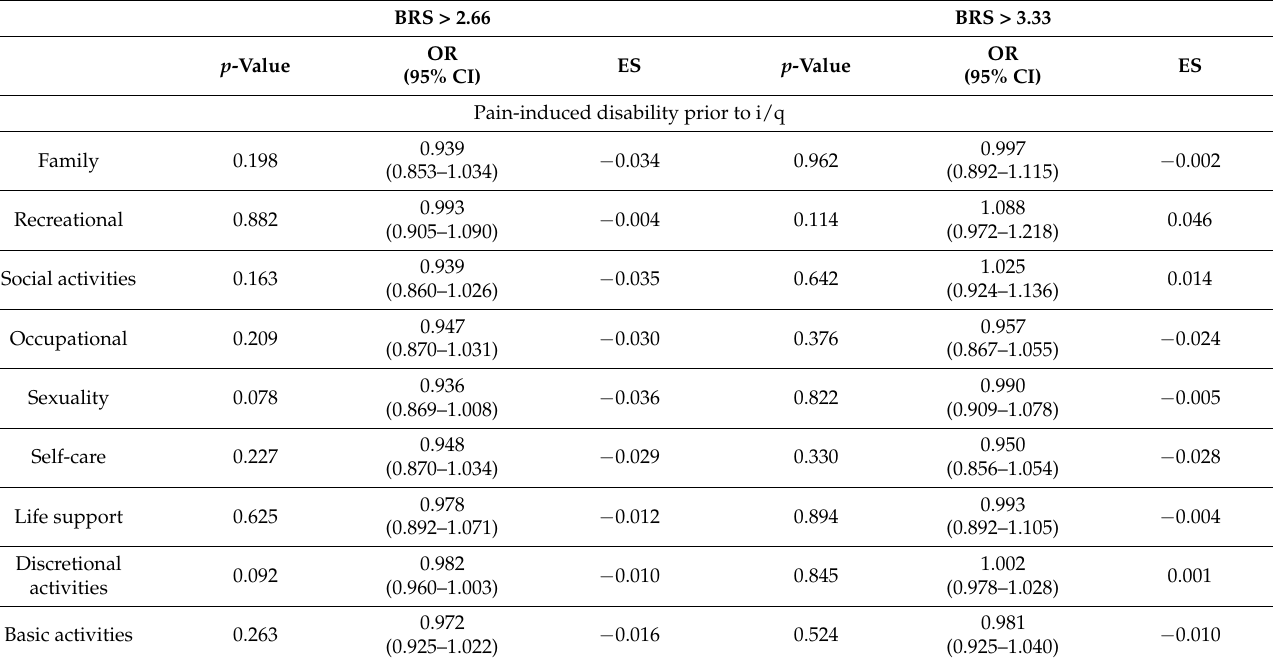
Table 6. Impact of pain-induced disability on resilience (univariate logistic regression analysis). BRS >